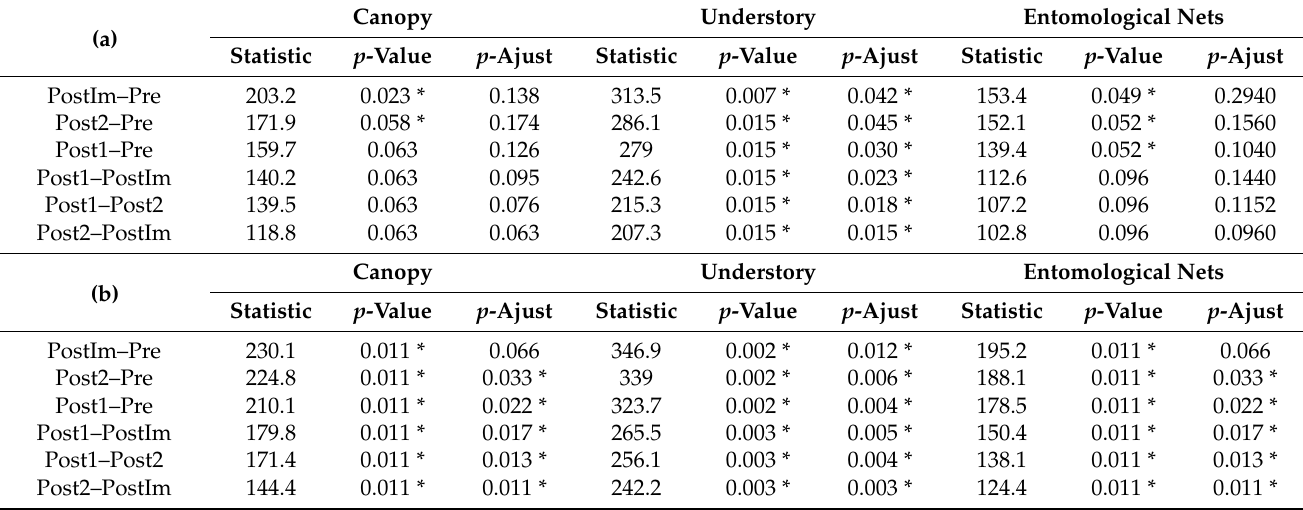
Table 2. Pairwise comparisons (manyglm analysis) of the association between the structure of the butterfly assemblages using occurrence (a) and abundance (b) data collected between October 2010 and November 2014 in the Santo Ant ô nio dam on the Madeira River in southwestern Amazonia in Brazil in four different flooding stages were Pre, PostIm, Post1 and Post2 using three sampling techniques Canopy, Understory, and Entomological nets. * indicates significant